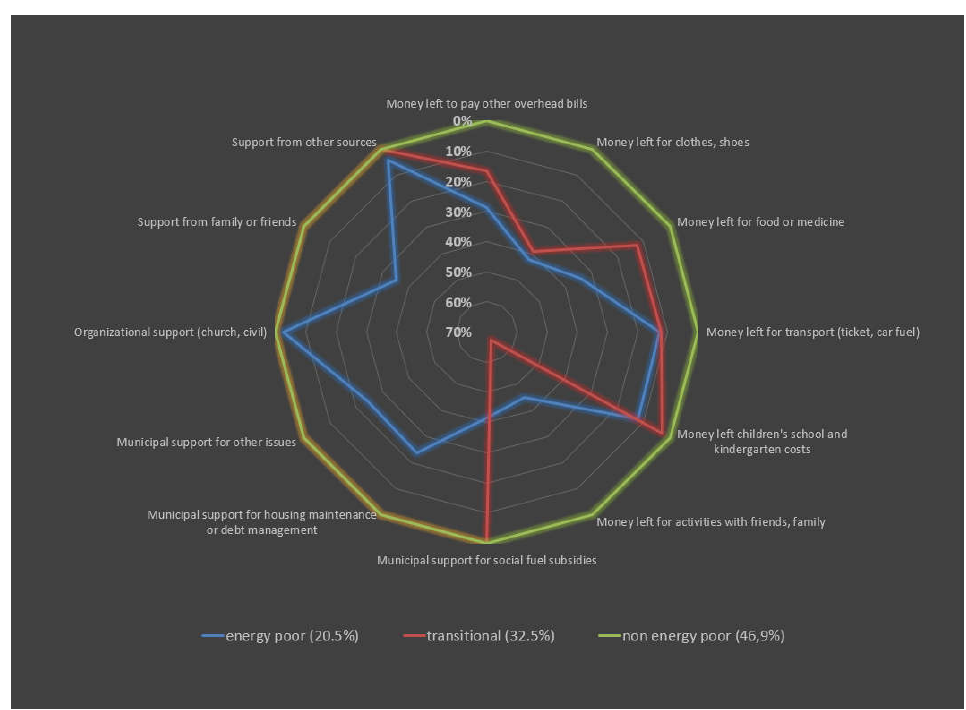
Figure 3. Cluster profiles: weighted proportion of respondents Compiled by the authors.